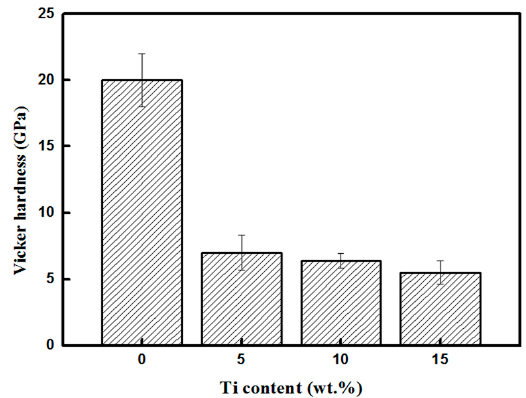
Materials 2018 , 11 , x FOR PEER REVIEW 7 of 12 Figure 4. Vickers hardness values of the composites infiltrated by the Al–Si–xTi alloy (Si: 10 wt.%).